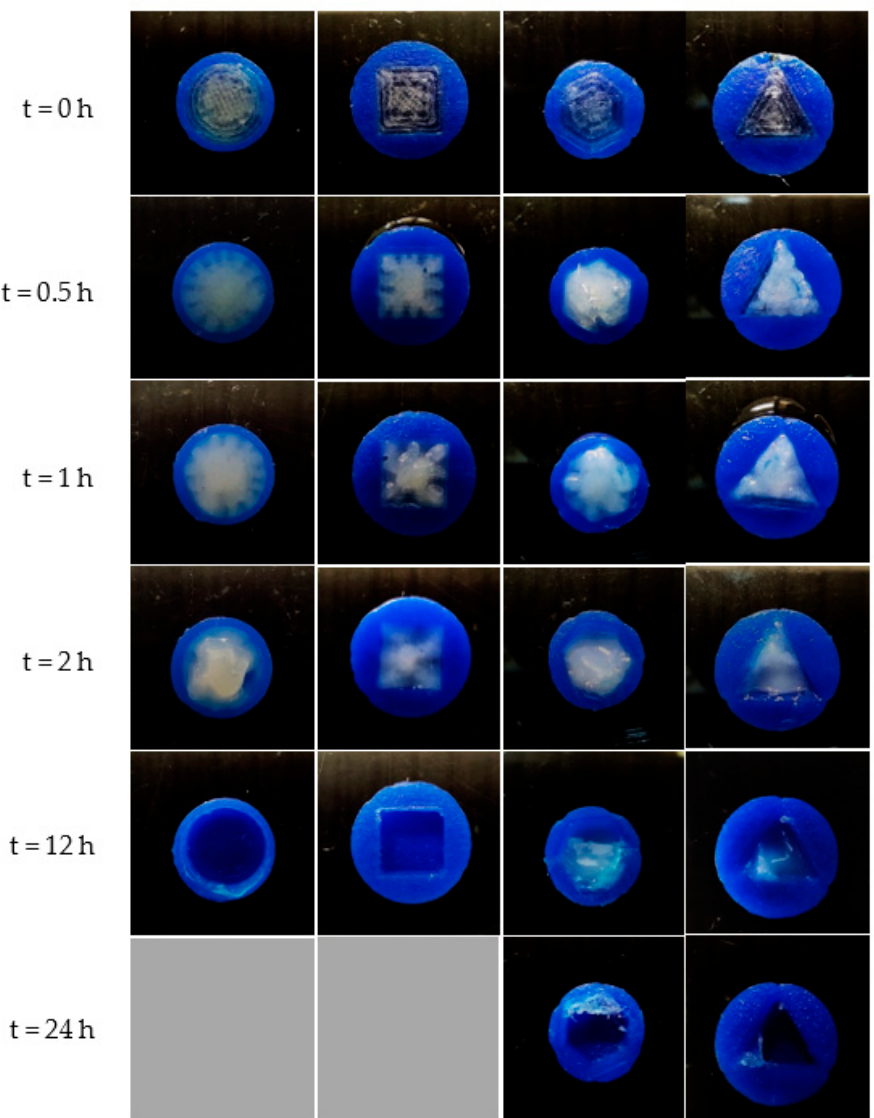
Figure 9. Top ‐ view images of FDP ‐ loaded 3D ‐ printed tablets with round ‐ , square ‐ , hexagon ‐ , and triangle ‐ shaped inner compartments during the dissolution test. triangle-shaped inner compartments during the dissolution